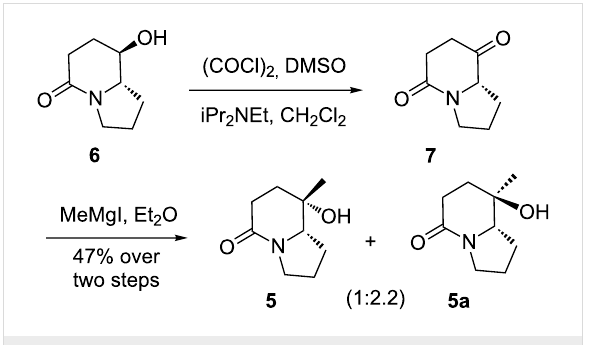
loids of dendrobatid poison frogs [4,5]. Forthermore, from the extracts of an unidentified Scheloribates sp . of mites, pumil- iotoxin 237A ( 3 ) was detected as a minor component